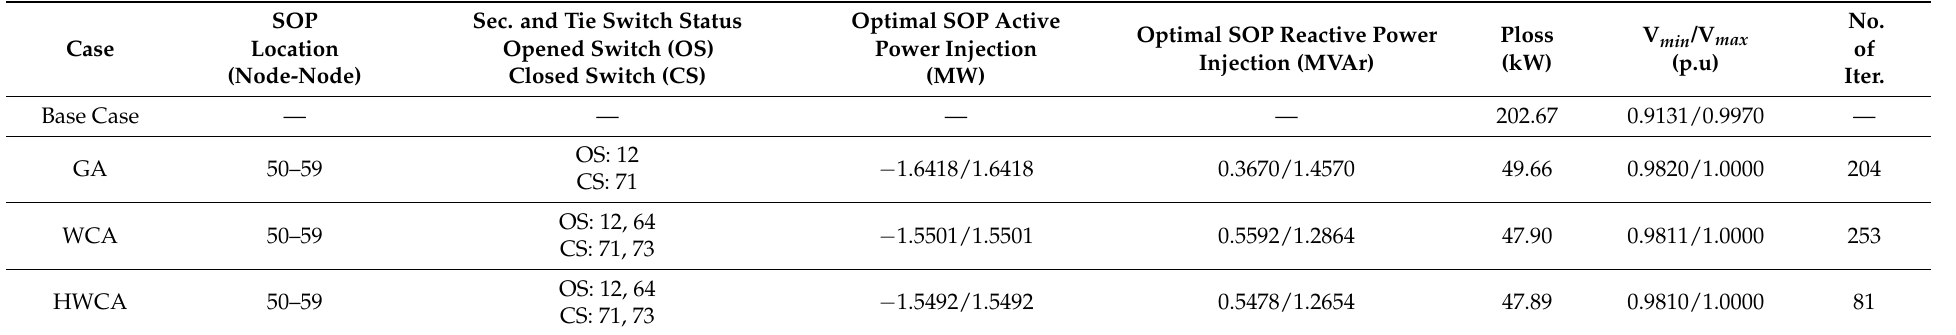
Table 4. Compared numerical results of HWCA for case 6 with WCA and GA for the 69-node